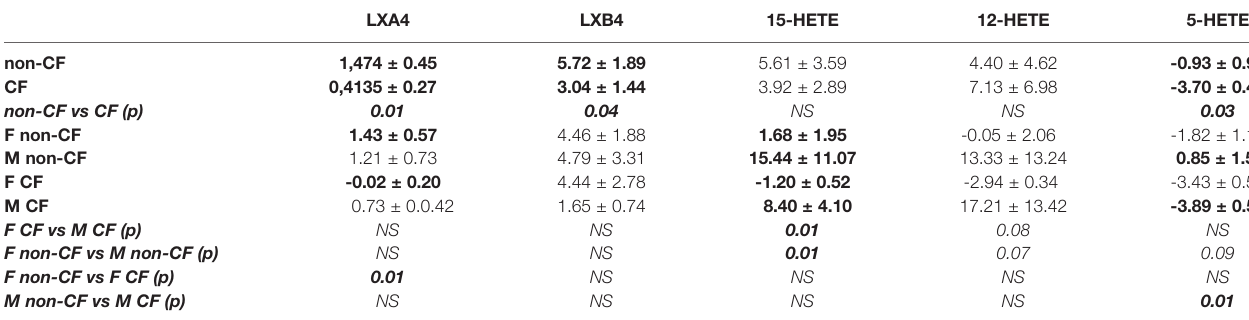
TABLE 2 | Arachidonic acid (AA) metabolites